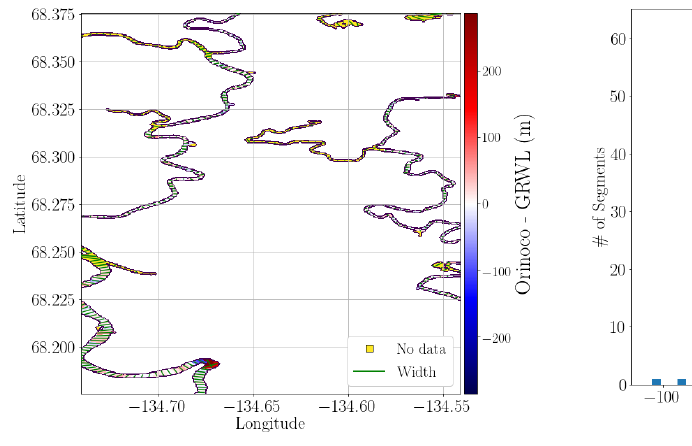
Figure 8. Comparison of GRWL and Orinoco over a subset of the Mackenzie (NR08). Top Row: comparison of channel centerlines and connectivity in ( a ) GRWL and ( b ) Orinoco . Bottom Row: ( a ) is the per segment difference in widths (when applicable) and ( d ) is the histogram of errors. Note that we also have removed segments whose corresponding node in the network is a junction or adjacent to one (see panel ( c ), “No